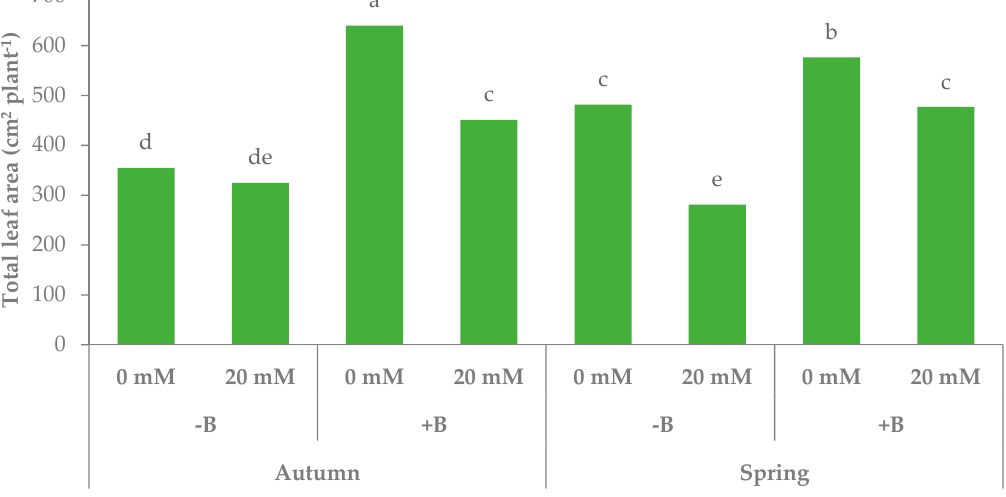
Figure 7. Total leaf area of leaf lettuce plants grown during autumn and spring in nutrient solutions containing different levels of NaCl, with (+B) or without (-B) bacterial biostimulant (bars with different letters are significantly different at p < 0.05, according to the LSD test).